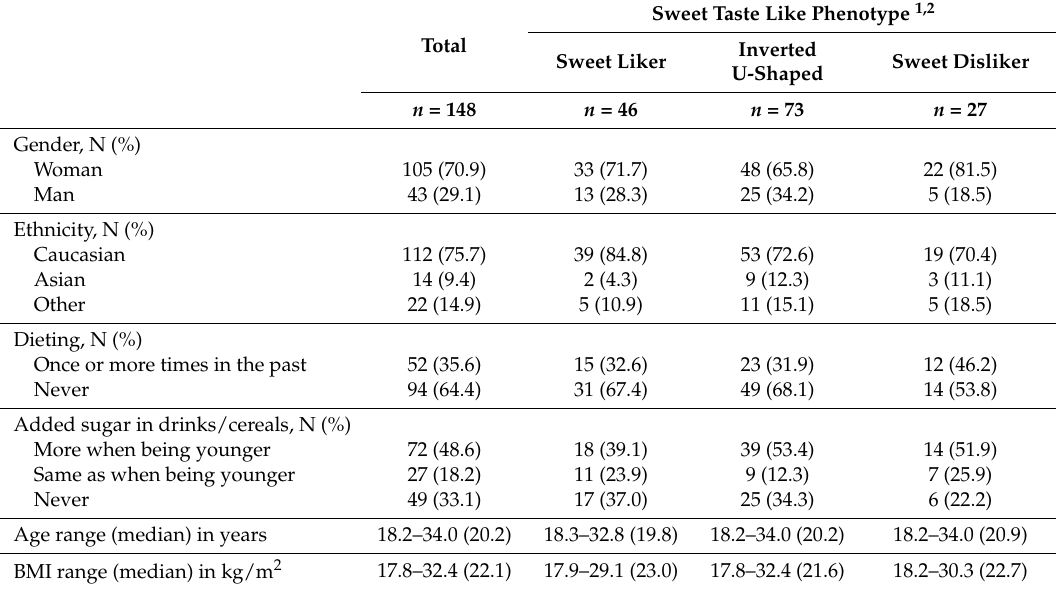
Table 1. Participant